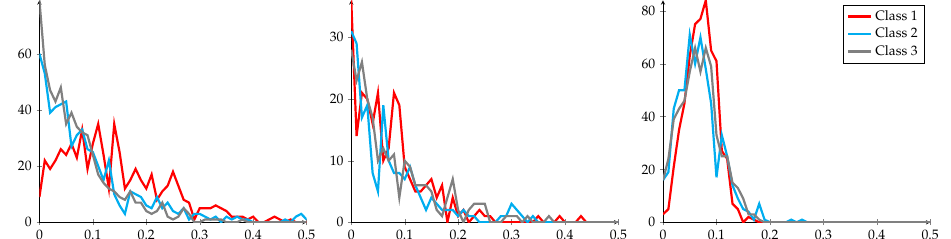
Figure 2. Distributions of an arbitrarily chosen feature for 3 novel classes with different preprocessing techniques: raw ( left ), batch norm ( middle ) and power transform ( right